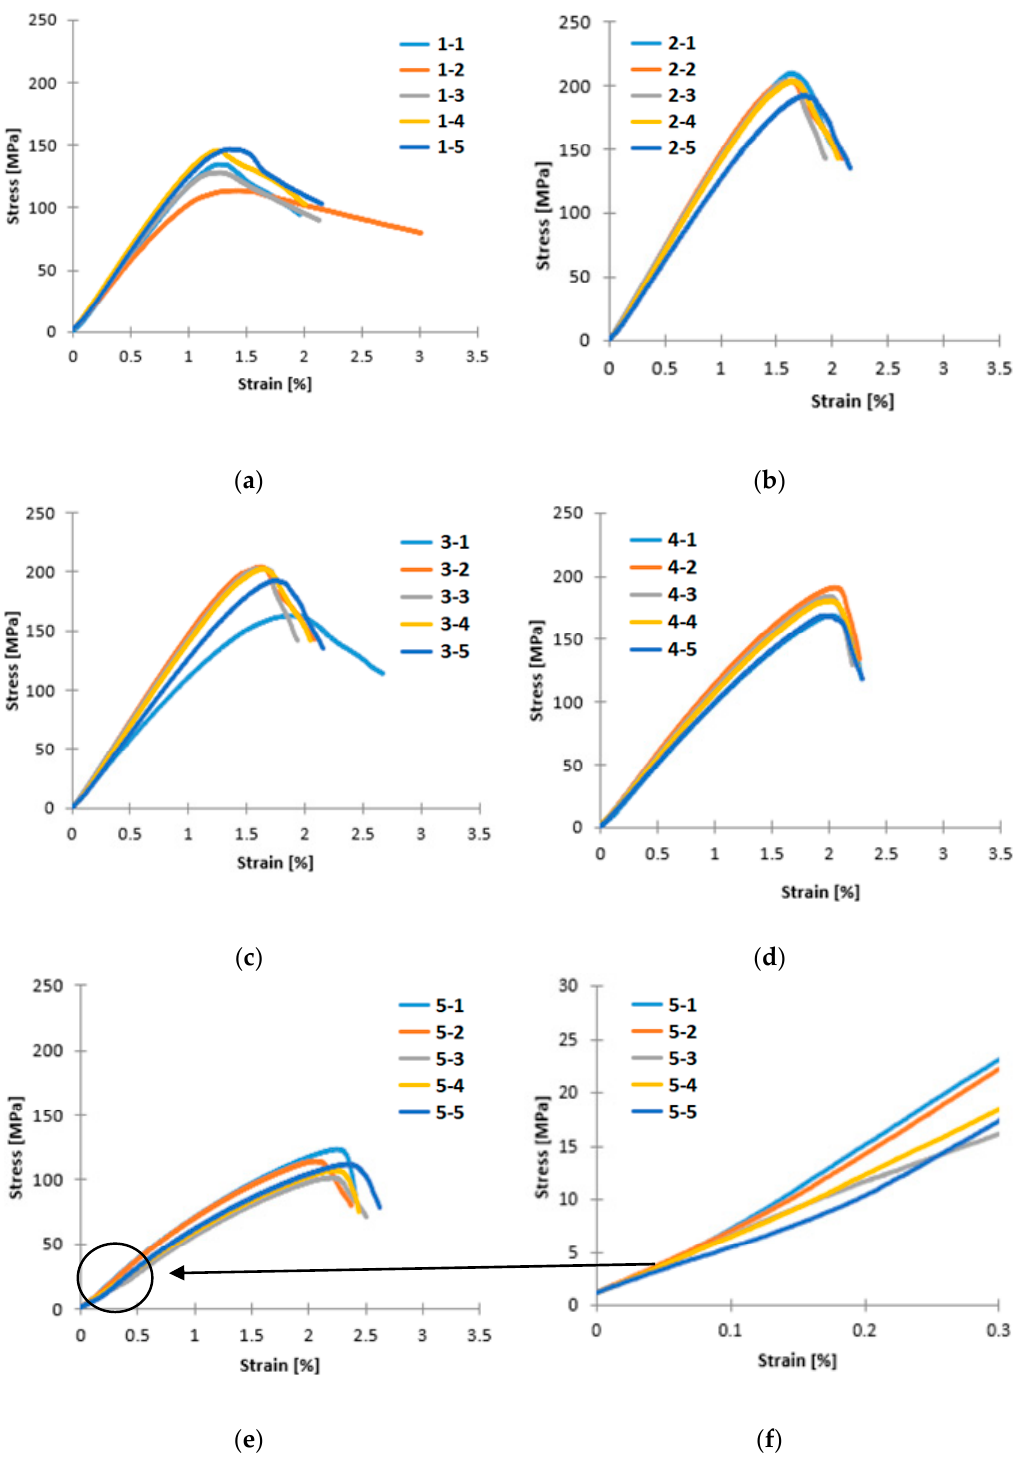
Figure 4. Flexural stress–strain curves for ( a ) sample 1, 100% rCF; ( b ) sample 2, 75% rCF and 25% flax; ( c ) sample 3, 50% rCF and 50% flax; ( d ) sample 4, 25% rCF and 75% flax; and ( e ) sample 5, 100% flax. ( f ) Crimp region of the stress–strain curve from sample 5.